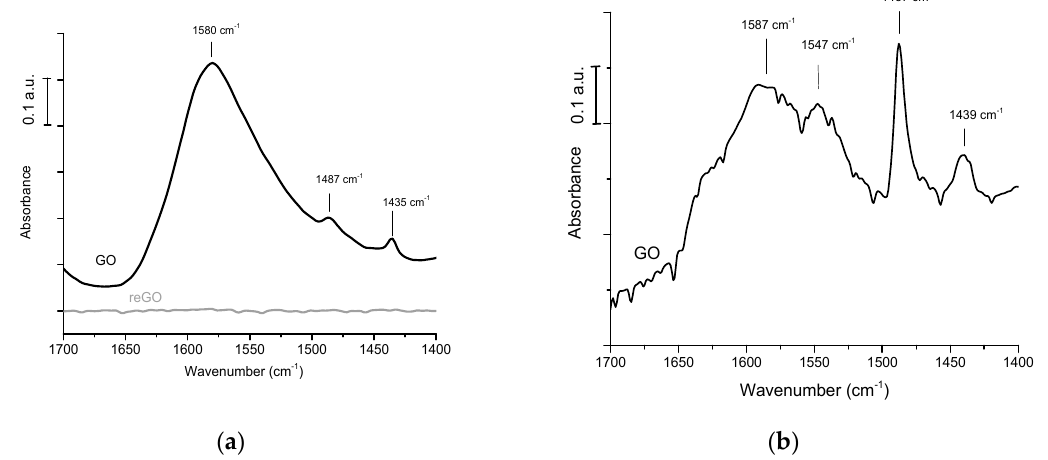
Figure 3. ( a ) Pyridine adsorption on GO and reGO pretreated at 150 °C and further vacuum treatment at 150 °C for 0.5 h and ( b ) pyridine adsorption on GO pretreated at ambient T and further vacuum treatment at 150 °C for 0.5 h.